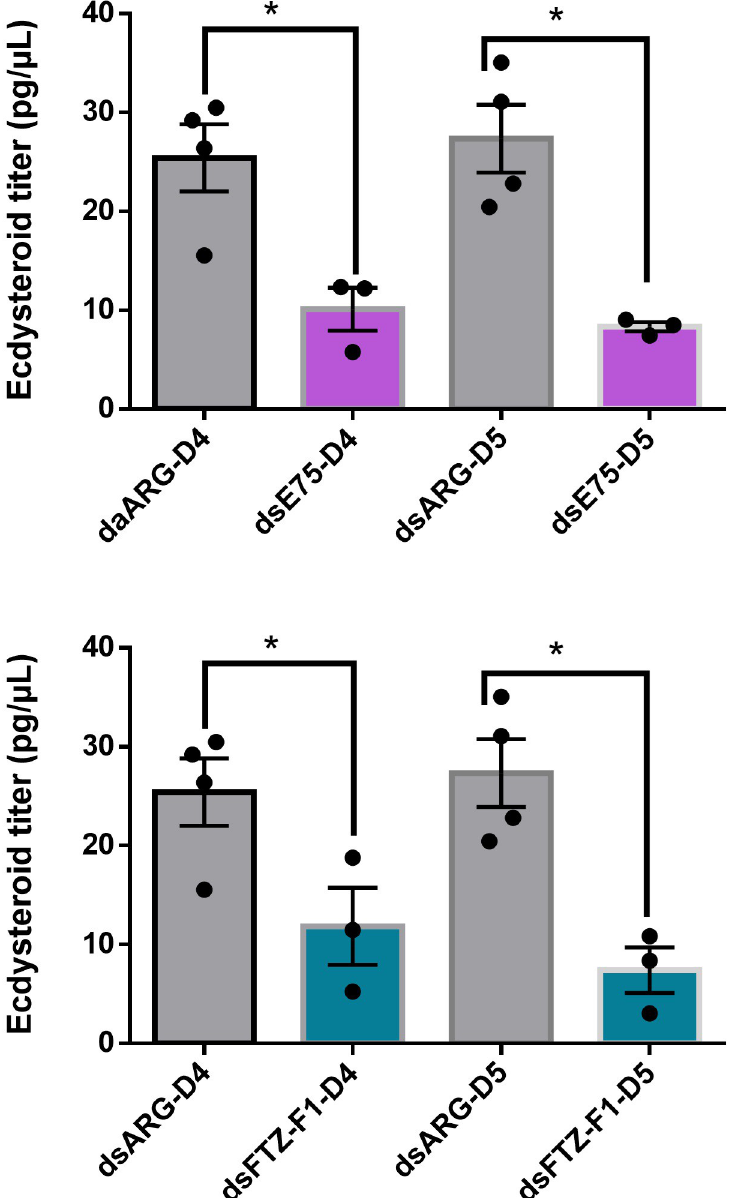
Fig 7. Effect of knockdown of FTZ-F1 and E75 on the hemolymph ecdysteroid titer in adult females at days 4 and 5 post blood meal. Bars represent mean ± SEM (n = 3–4). The transcript levels were quantified using RT-qPCR and analyzed using the 2 − ΔΔ Ct method. Data are means ± SEM (n = 3–4). Rp49 and β -actin were used as reference genes. Statistical analysis was performed by Student’s t-test. � p < 0.05. ecdysteroid titer as is necessary during vitellogenesis for egg production. Knockdown of the ecdysone response genes in R . prolixus by RNAi significantly decreases Vg1 and Vg2 expres- sion in the fat body and ovaries, reduces the titer of ecdysteroid in the hemolymph, and inter- feres with normal egg production. Further evidence of feedback is shown by knockdown of E75 , E74 or FTZ-F1 , which downregulates the transcripts in the fat body and ovary for EcR and USP at day 4 PBM. In addition, knockdown of E75 , E74 or FTZ-F1 expression results in a